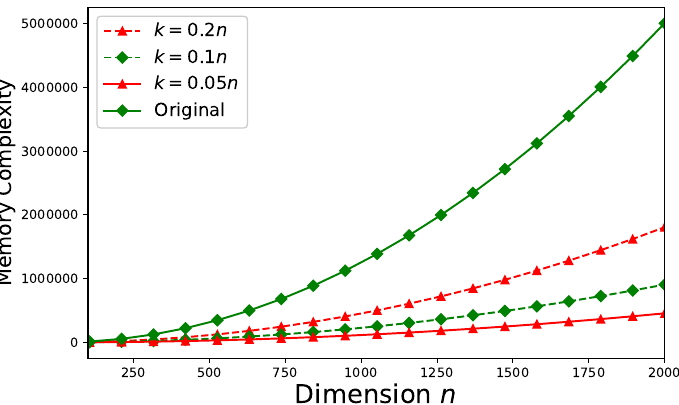
Figure 12. The memory -complexity versus n for a consistent system ( m = 1.25 n ).